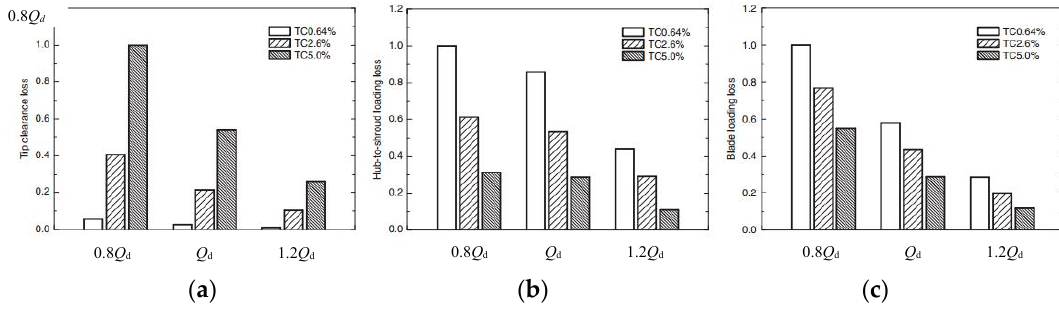
Figure 25. ( a ) Tip-clearance loss; ( b ) hub-to-shroud loading loss; ( c ) blade-loading loss for different tip clearances at 0.8 Q d , 1.0 Q d , and 1.2 Q d [54].